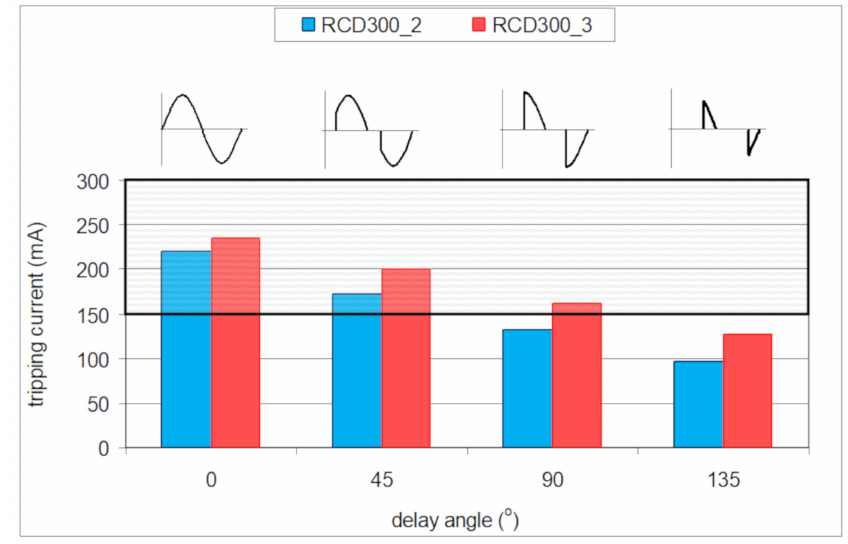
Figure 20. Tripping current of two 300 mA A-type RCDs for the following current delay angles: 0 ◦ , 45 ◦ , 90 ◦ , and 135 ◦